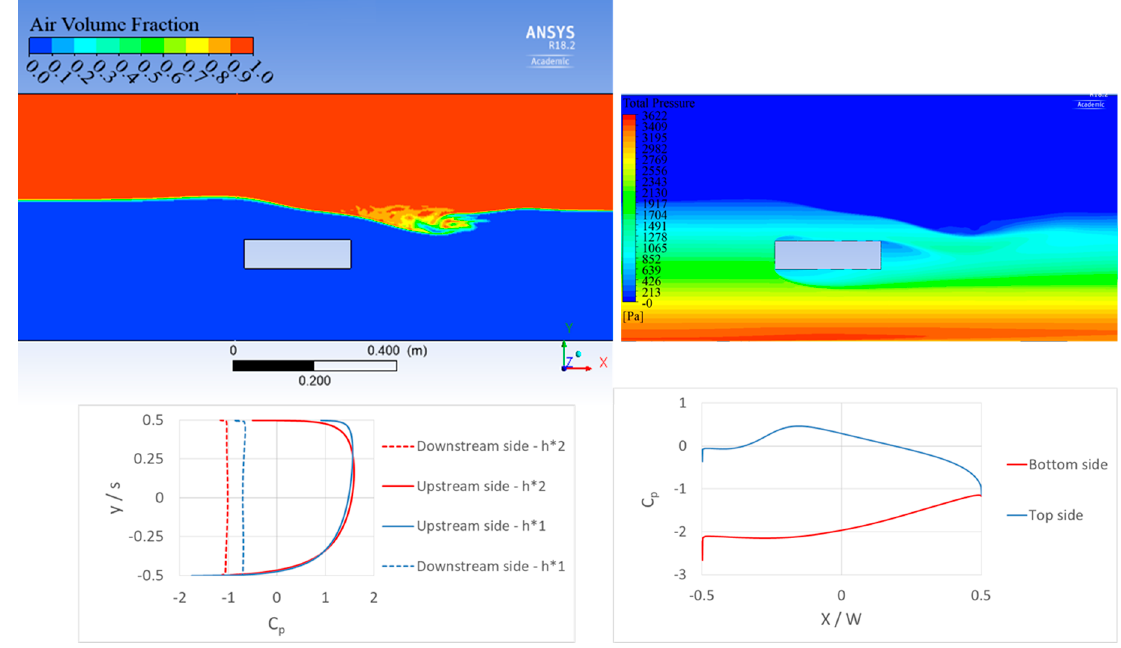
Figure 19. ( Top left ) Hydraulic jump downstream of the bridge, h* = 2, Fr s = 0.97. ( Top right ) Total pressure (Pa) in the flow around the deck. ( Bottom left ) Pressure coefficient on upstream and downstream faces of the deck. ( Bottom right ) Pressure coefficient on upper and lower faces of the deck.